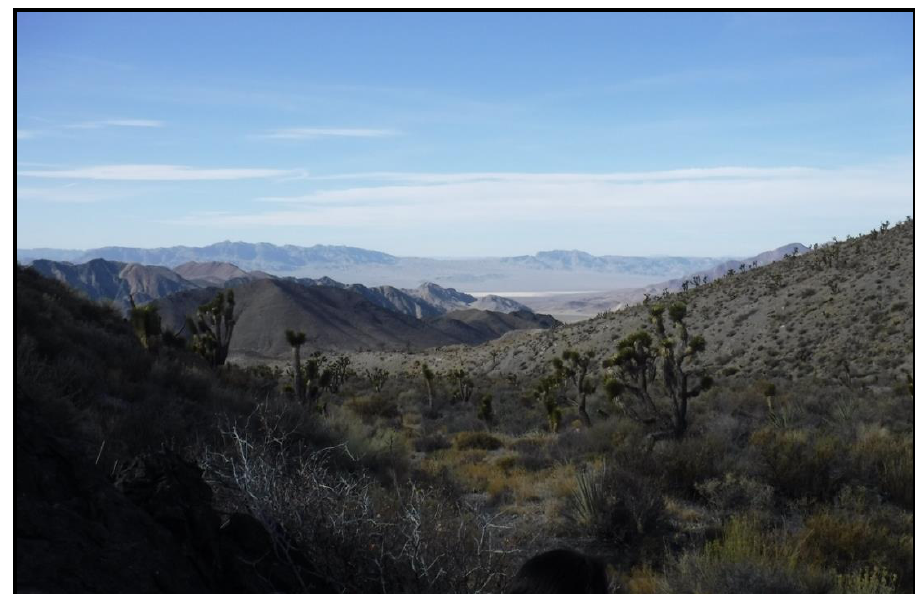
Figure 5. A Cultural Landscape View West of White Rock Spring (Source: Stoffle).